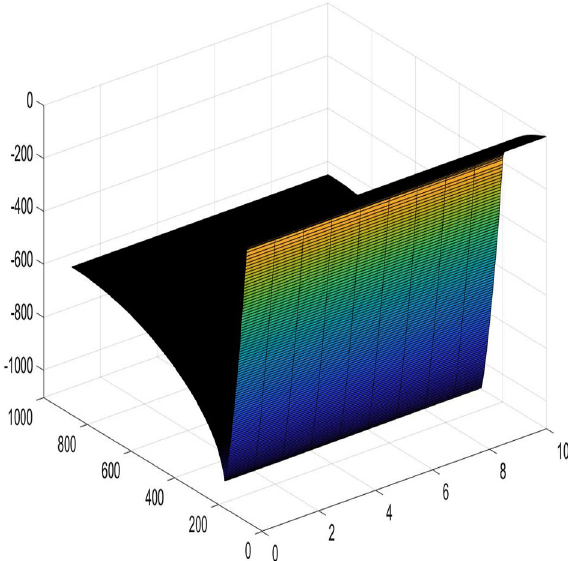
Figure 10. A 3D graph for the changes of U 1000